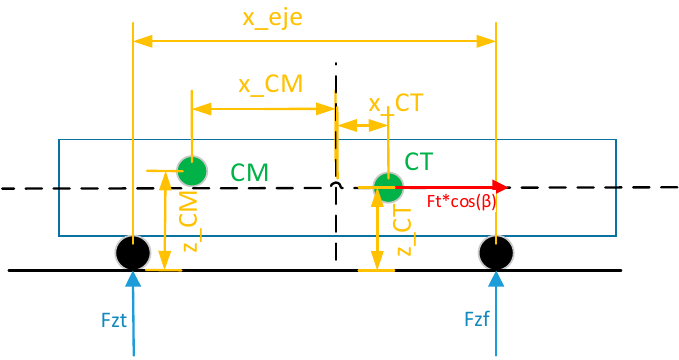
Figure 15. Calculation of the loads on the wheels in motion. XZ plane.